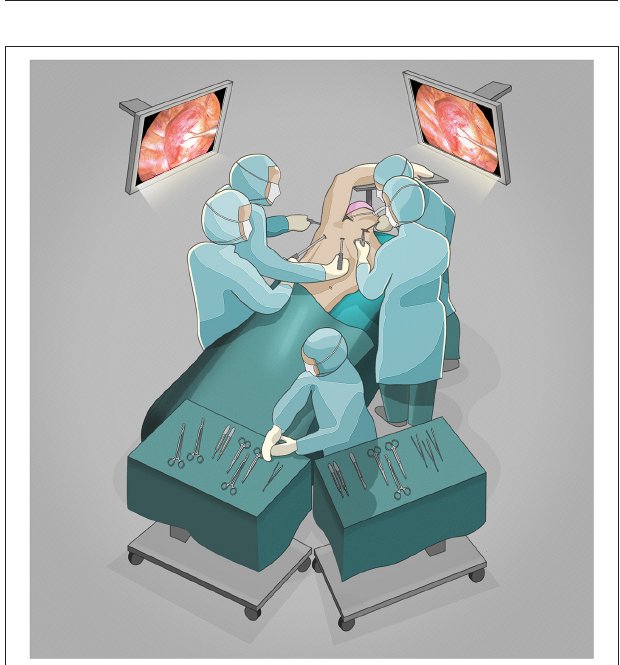
FIGURE 1 | Three-dimensional computed tomography scan reconstruction showing a posterior mediastinal mass, most probably connected with the thyroid by a small tissue bridge and caudally in juxtaposition to the right upper lobe artery.